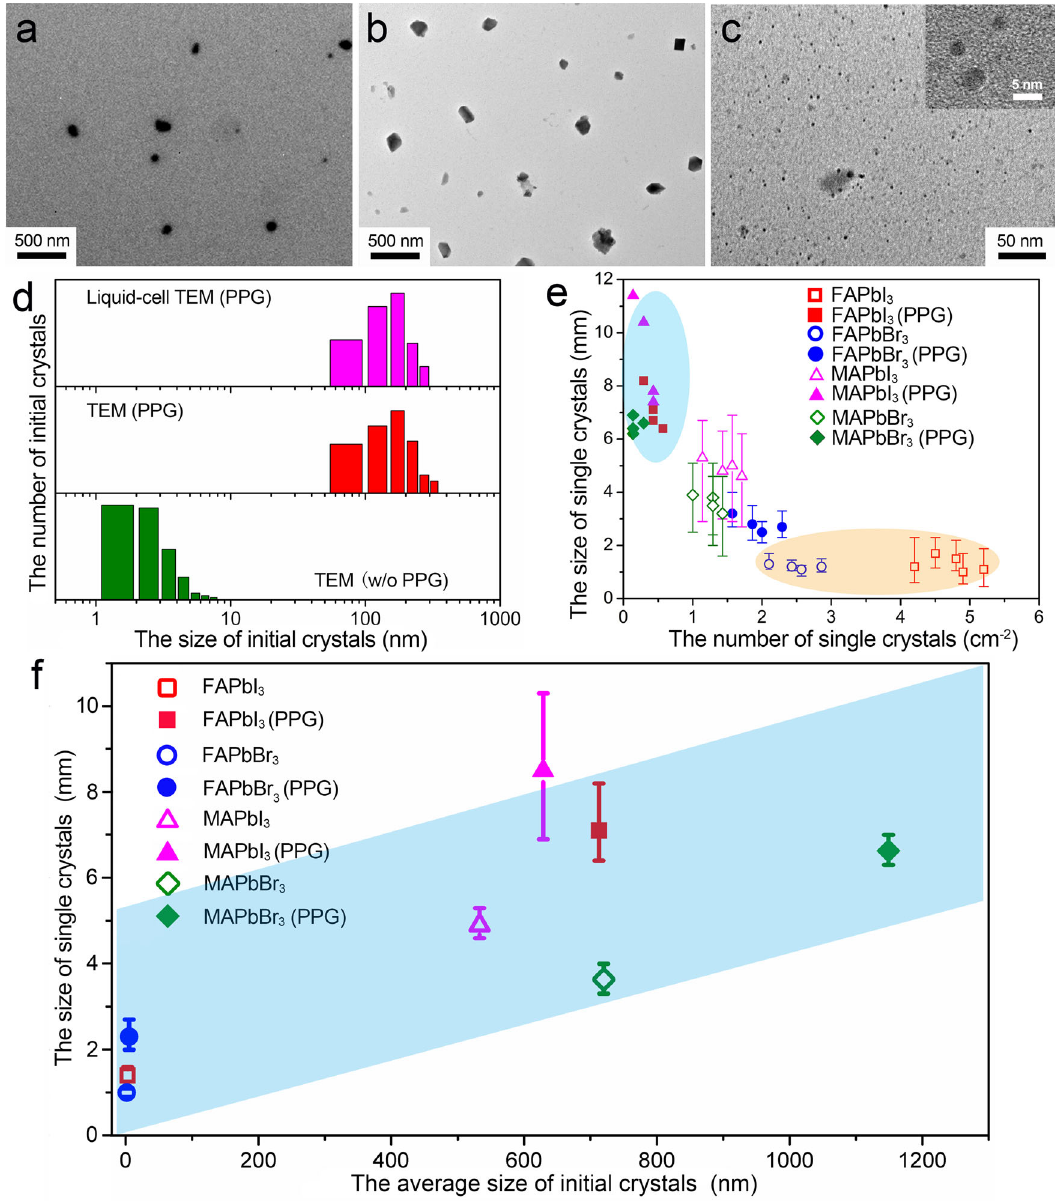
Fig. 4 The characterization of initial nanocrystals in growth solutions at the initial growth stage. a TEM images of FAPbI 3 initial nanocrystals in FAPbI 3 / (GBL + PPG-3000) solution using a liquid cell. b and c FAPbI 3 /(GBL + PPG-3000) solution and FAPbI 3 /GBL solution on carbon fi lm, respectively. d Size distribution of FAPbI 3 initial nanocrystals. e The correlations between the size distribution and the number of OIHPs single crystals. The error bars indicate the single crystal size range. f The correlations between single crystal sizes and the initial nanoparticle